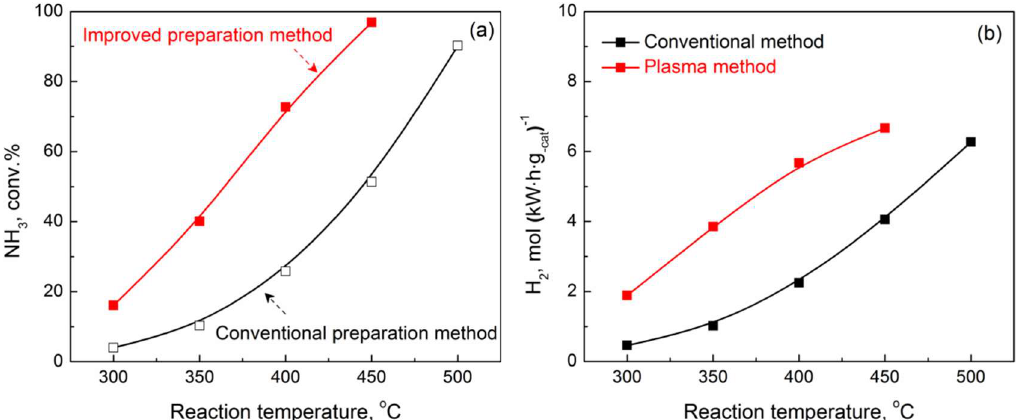
Figure 5. Plasma-catalytic NH 3 decomposition over Co/fumed SiO 2 catalyst with different preparation methods: ( a ) the conversion of NH 3 ; ( b ) the energy efficiency of H 2 generation (NH 3 feed rate 40 mL/min −1 , supported catalyst 0.88 g, discharge gap 3 mm, discharge frequency 12 kHz; The reaction temperature originated from electric heat released by discharge, and was determined using an IR camera and thermocouple tightly attached to the outer wall of the reactor [12]).